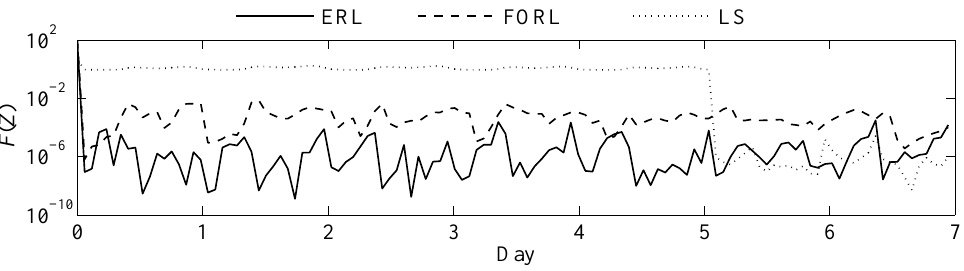
Figure 7. Error function values over seven days on the IEEE 57-bus power